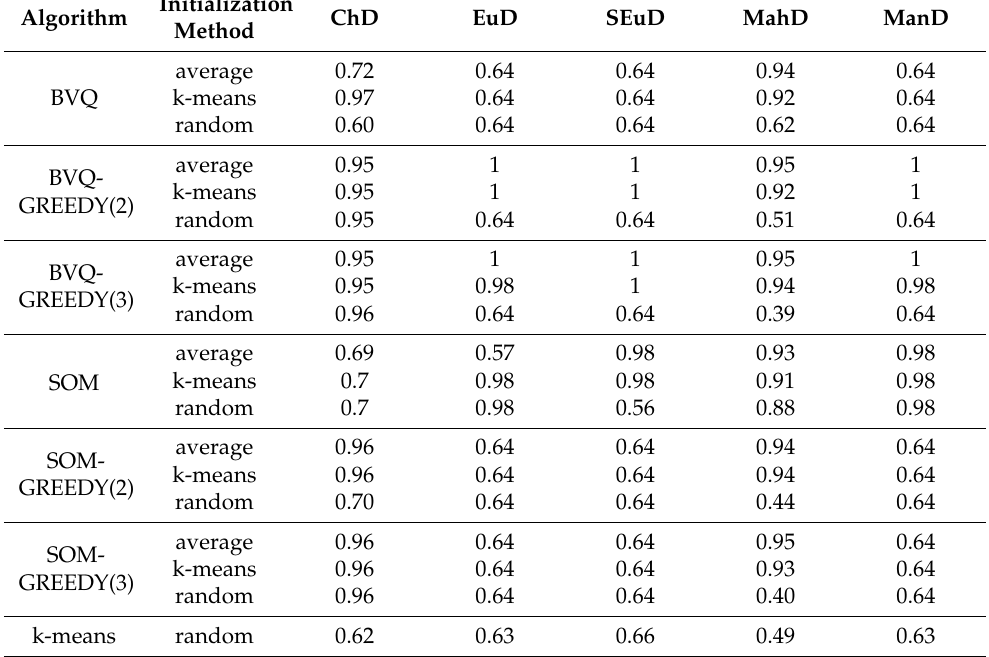
Table 7. Accuracy of device clustering for BVQ, SOM, BVQ-GREEDY(2), BVQ-GREEDY(3), SOM- GREEDY(2) and SOM-GREEDY(3) algorithms (three-batch mixed